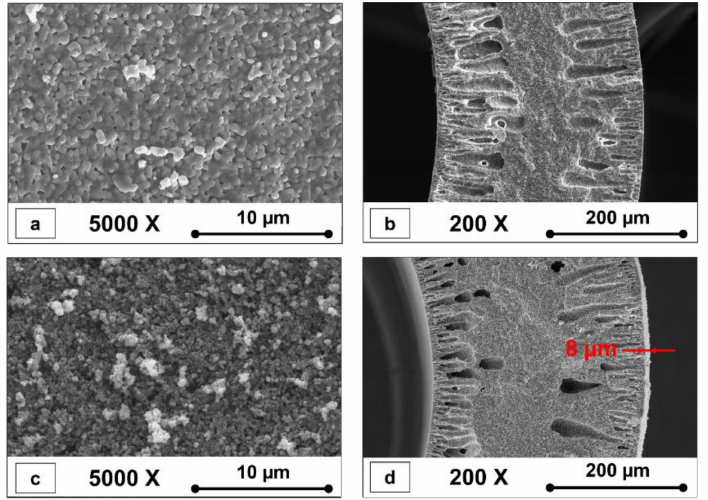
Figure 2. SEM images of ( a ) external surface and ( b ) cross-section of Al 2 O 3 HF support, and ( c ) surface and ( d ) cross-section of TiO 2 /GO-Al 2 O 3 HF NF